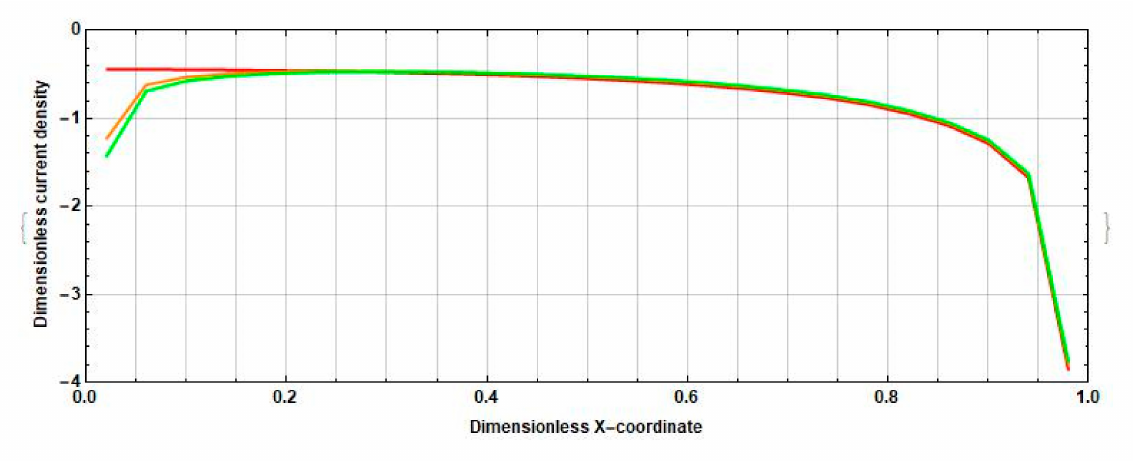
Figure 2. Distribution of stationary current density over the cathode surface at di ff erent distances between the cathodes (red line, 2˜ l c = 0; orange line, 2˜ l c = 0.5; green line, 2˜ l c =